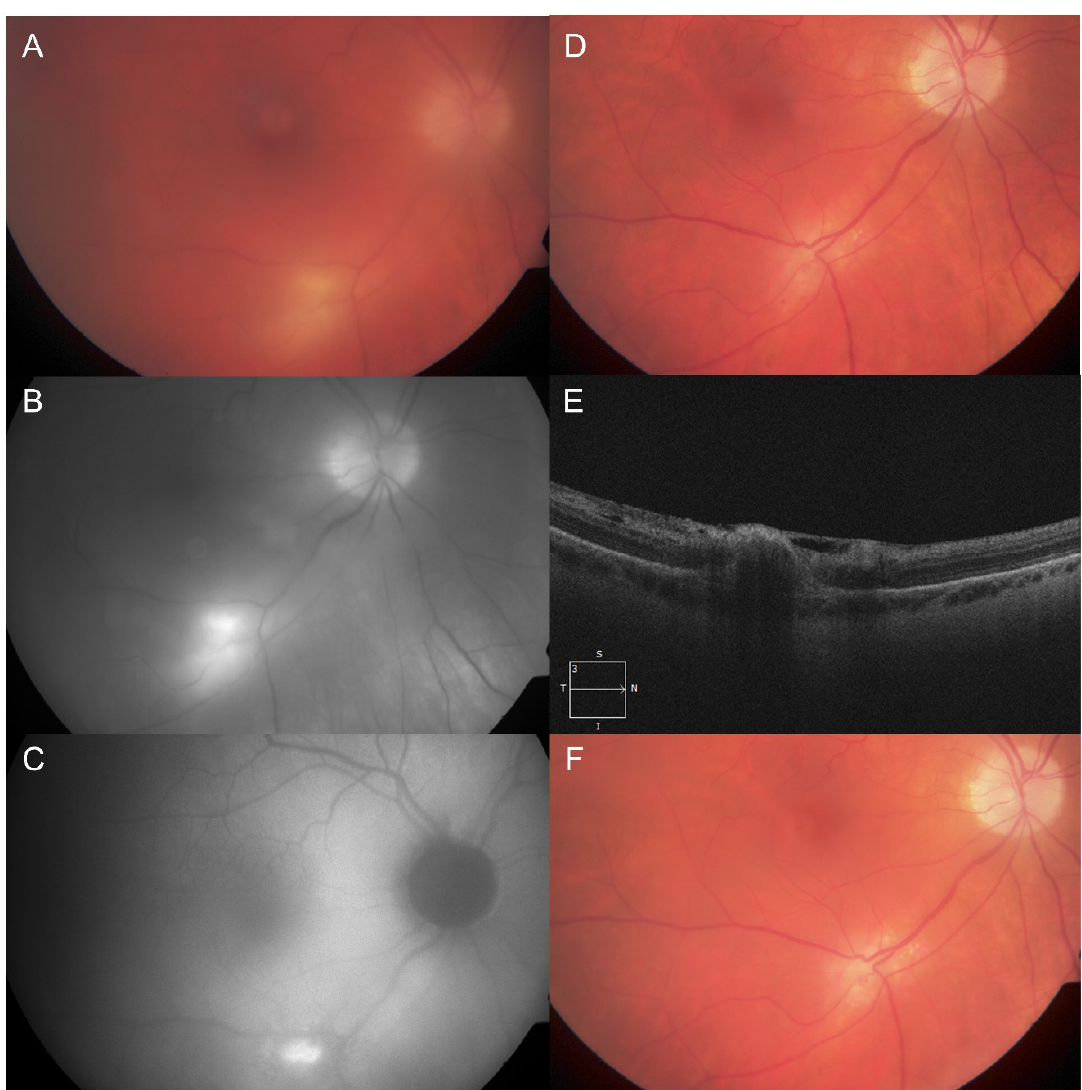
Figure 1. Case 1 with active toxoplasmosis retinochoroiditis following a diagnosis of coronavirus disease 2019 (COVID-19) and recurrence after COVID-19 vaccination. ( A ) Color fundus photography showing a single, white, deep chorioretinal lesion along the inferior arcade with vitritis at initial presentation. ( B ) Initial red-free monochromatic fundus photograph showing the same lesion which becomes more apparent. ( C ) Initial fundus autofluorescence showing a hyperautofluorescent lesion with distinct borders corresponding to the retinochoroiditis. ( D ) Four months after presentation, the lesion is now cicatricial without vitritis with ( E ) a horizontal optical coherence tomography scan through the lesion. ( F ) The patient had a recurrence 1 month later, 8 days after his first COVID-19 vaccine dose.